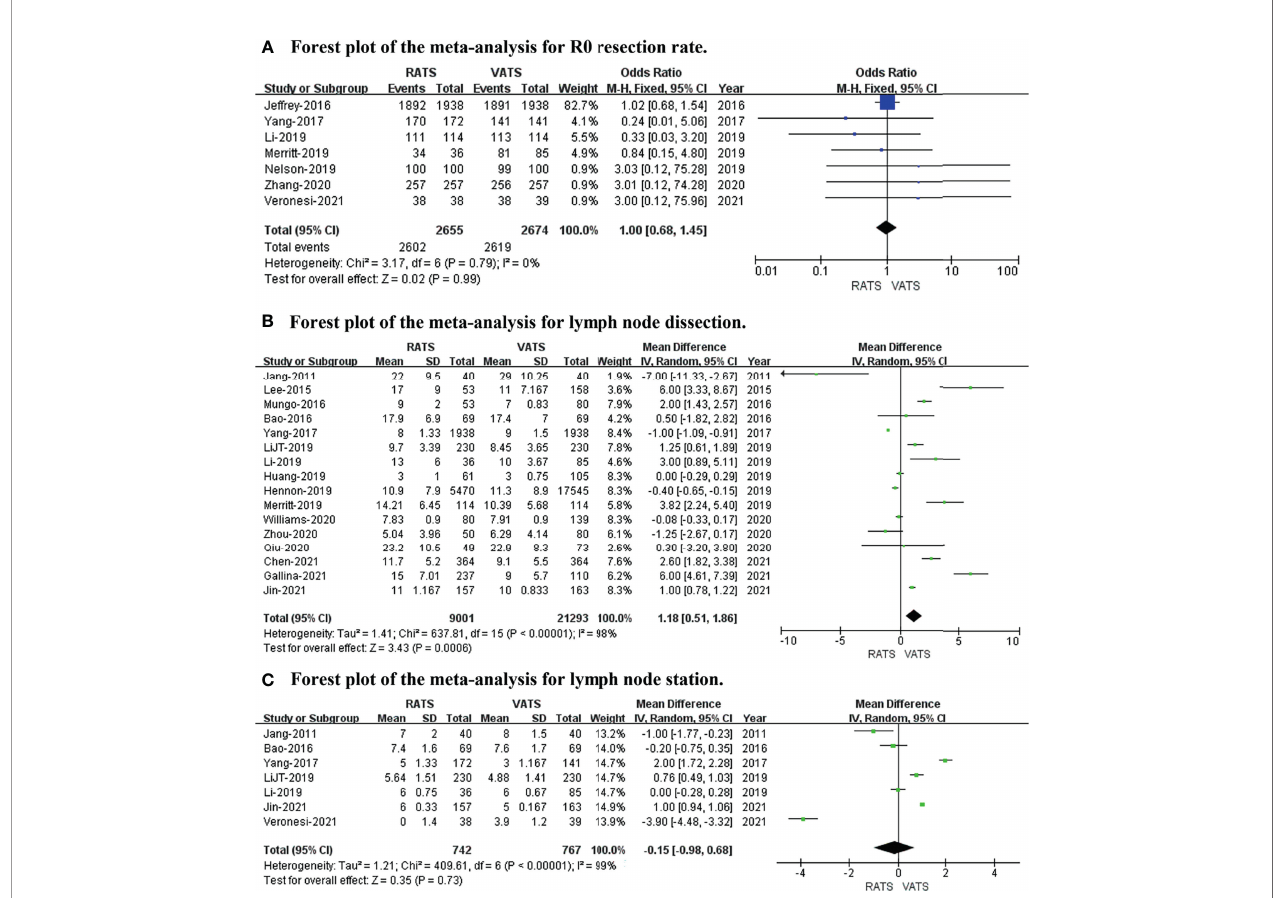
FIGURE 4 | Forest plot of the meta-analysis for short − term oncological outcomes. (A) Forest plot of the meta-analysis for the R0 resection rate. (B) Forest plot of the meta-analysis for lymph node dissection. (C) Forest plot of the meta-analysis for lymph